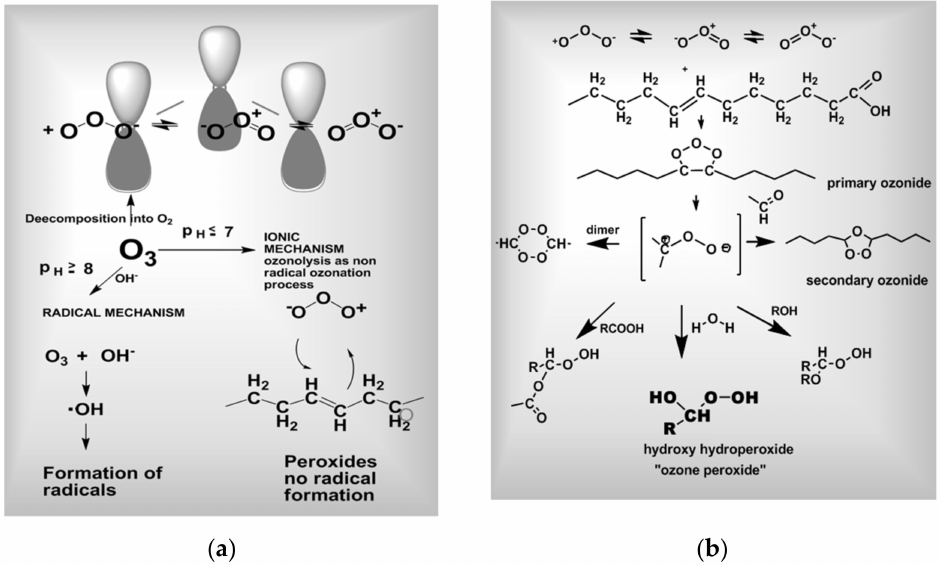
Figure 3. ( a ) Molecular structure. Radical and ionic reaction mechanisms of ozone modified after [9]. ( b ) Ozone reaction with isolated double bonds, i.e., ozonolysis according to Criegee 1953, 1975 [11,12]. The hydroxy hydroperoxides, here, “ozone peroxides” are understood as the pharmacologically active